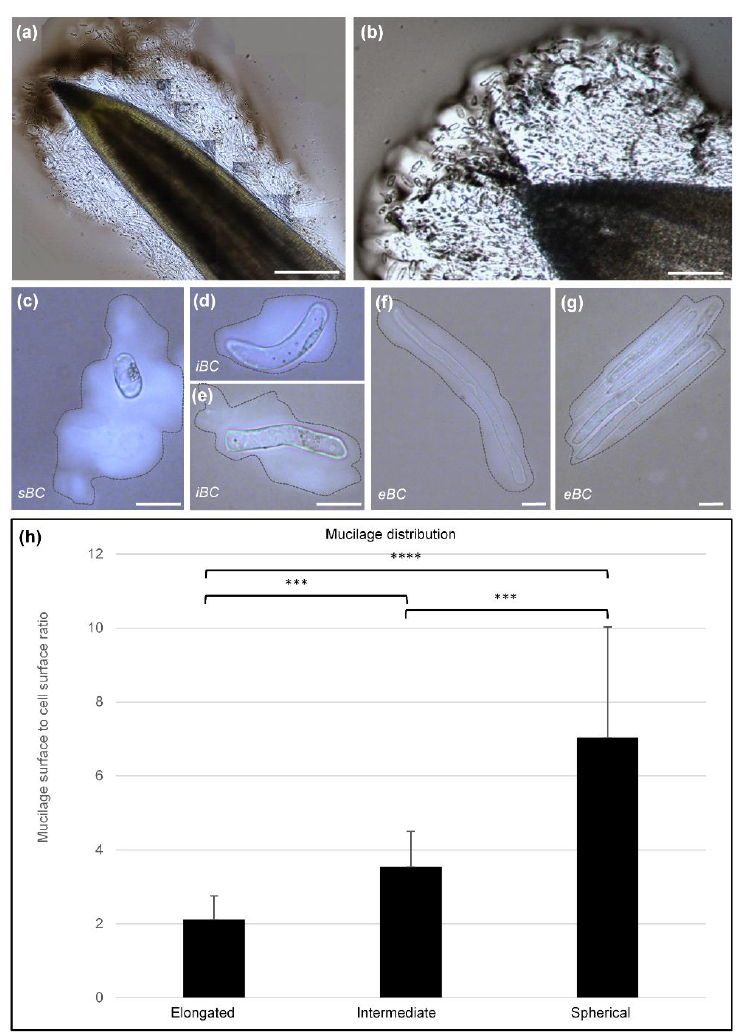
Figure 4. Visualization of secreted mucilage using India ink staining. ( a , b ) Light microscopy images showing an abundant slimy mucilage present around the root tip and embedding border cells. ( c – g ) images showing different cell types and their secreted mucilage (stained with India ink and delimited by a dashed line). ( h ) Histograms represent quantitative data indicating the proportion of mucilage surface surrounding each morphotype. R is the mucilage surface/cell surface ratio. Each histogram represents the ratio of 20 cells per morphotype, from 30 biological replicates. Kruskal–Wallis multiple comparisons test used with Bonferroni’s correction. sBC, spherical border cells; iBC, intermediate border cells; eBC, elongated border cells.; m, mucilage. Scale bars: ( a ) 300 µm; ( b ) 100 µm; and ( c – f ) 40 µm. *** P ≤ 0.001, **** P ≤ 0.0001